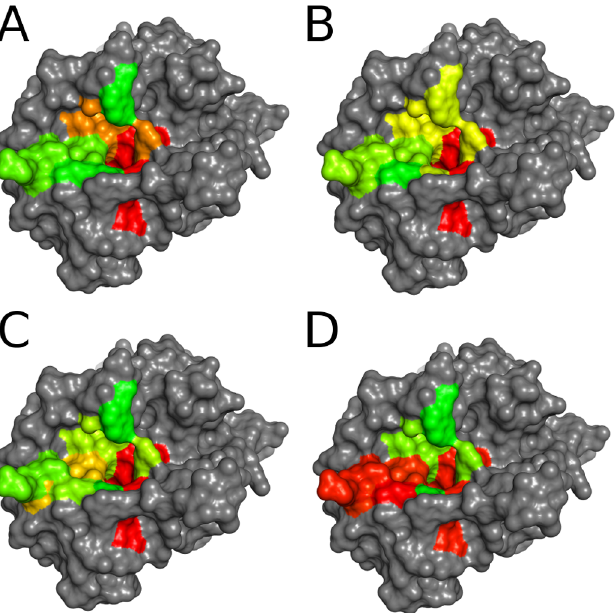
Fig 3. Water thermodynamics within the thrombin binding site in comparison with cleavage entropy. Cleavage entropy mapped to thrombin sub-pockets (A) with colors ranging from red (specific) to green (unspecific) in comparison with sub-pocket average translational entropy of water (B), orientational entropy of water (C) and solute-water enthalpic interactions (D) with colors ranging from red (high ordering and strong interactions) to green (low ordering and weak interactions). (B) and (C) show strong correlation with binding specificity (A), whereas enthalpic interactions with water are not as predictive (D). See Figure B in S1 File for a mapping based on ranks rather than absolute values.